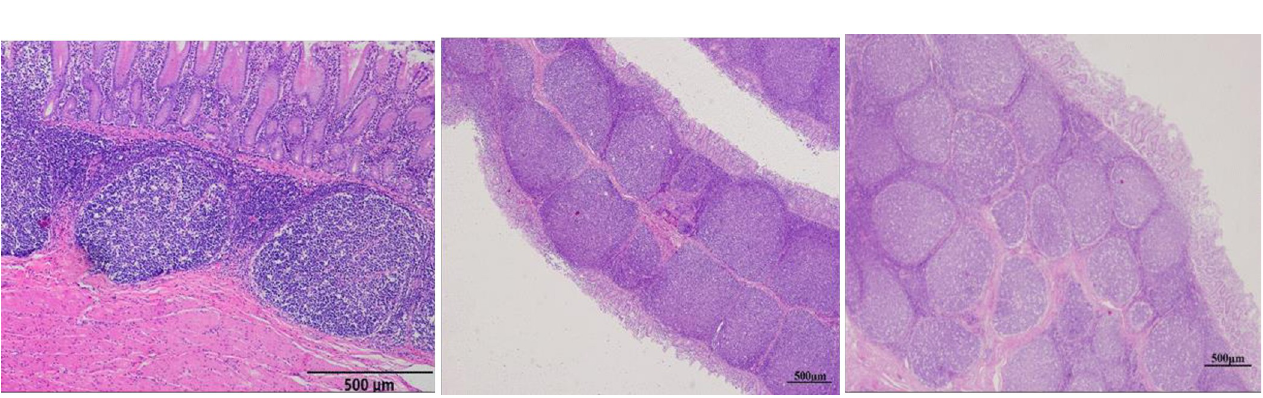
Fig 8. Organization of the aggregated lymphoid nodules. The lymphoid follicles were arranged in submucosa in a single row (A); within the fold in 2 rows (B); some follicles dispersed within the folds in more rows with multiple shapes and sizes (C). (H and E, 40x).